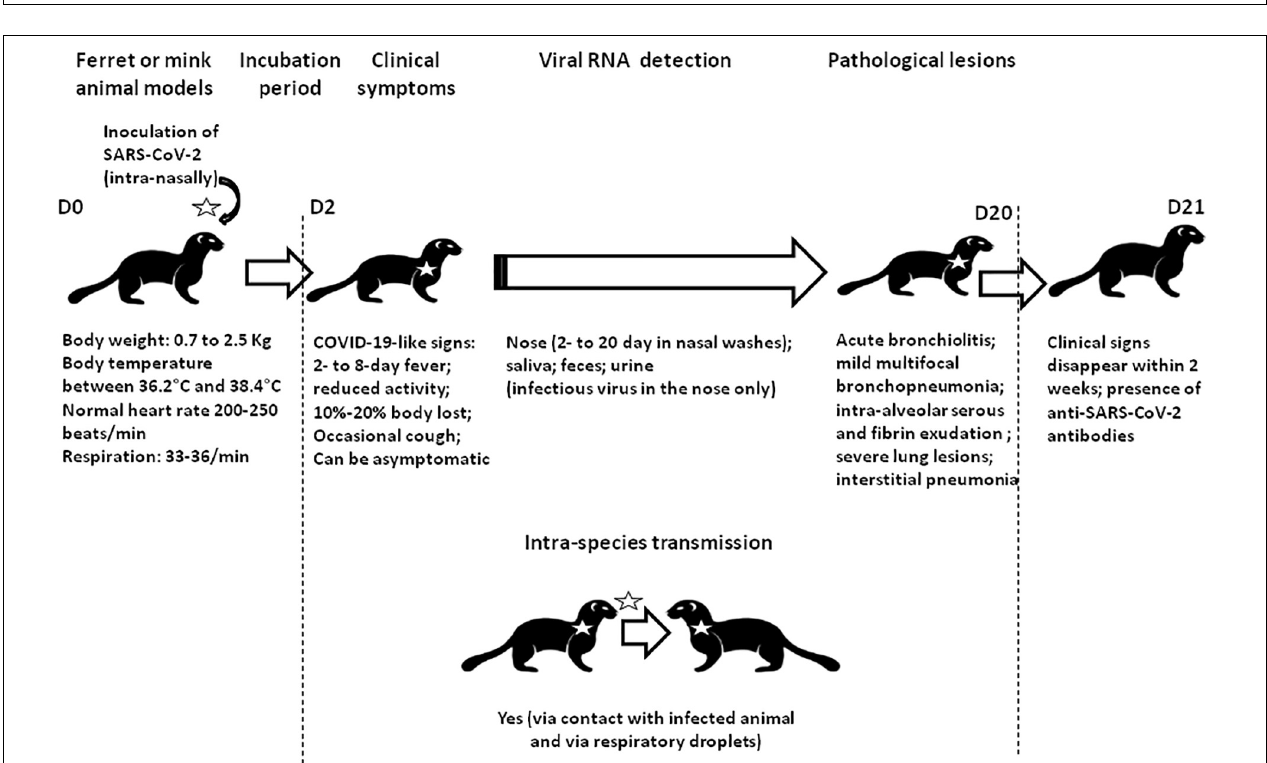
FIGURE 1 | Schematic representation of the experimental infection of ferrets and minks by SARS-CoV-2. All naïve animals became febrile and most collected specimens were positive for viral RNA. The isolation of infectious viral particles was sometimes possible from nasal washes. Transmission to naïve animals was observed following direct contact with infected animals (close but in different cages). Clinical sign and histological abnormalities are